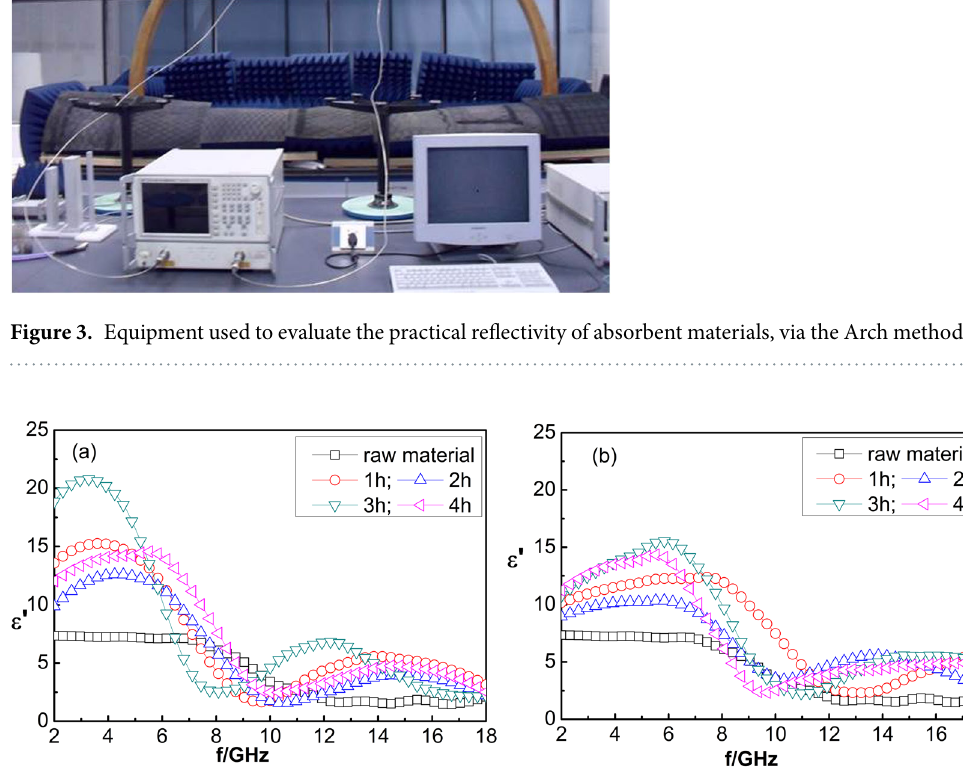
Figure 4. Real part ( ε ′ ) of the complex dielectric constant of CNT composites heat-treated for 1, 2, 3, and 4 h at temperatures of 700 °C and 900 °C; ε ′ of the untreated composites is denoted as 0